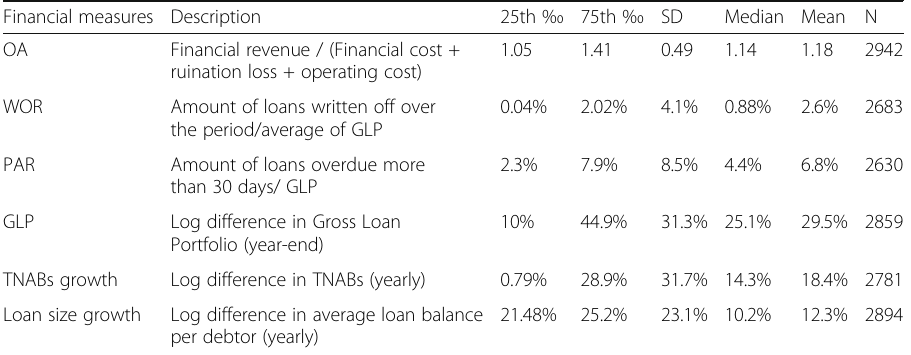
Table 2 Explanation of Financial Measures Financial measures